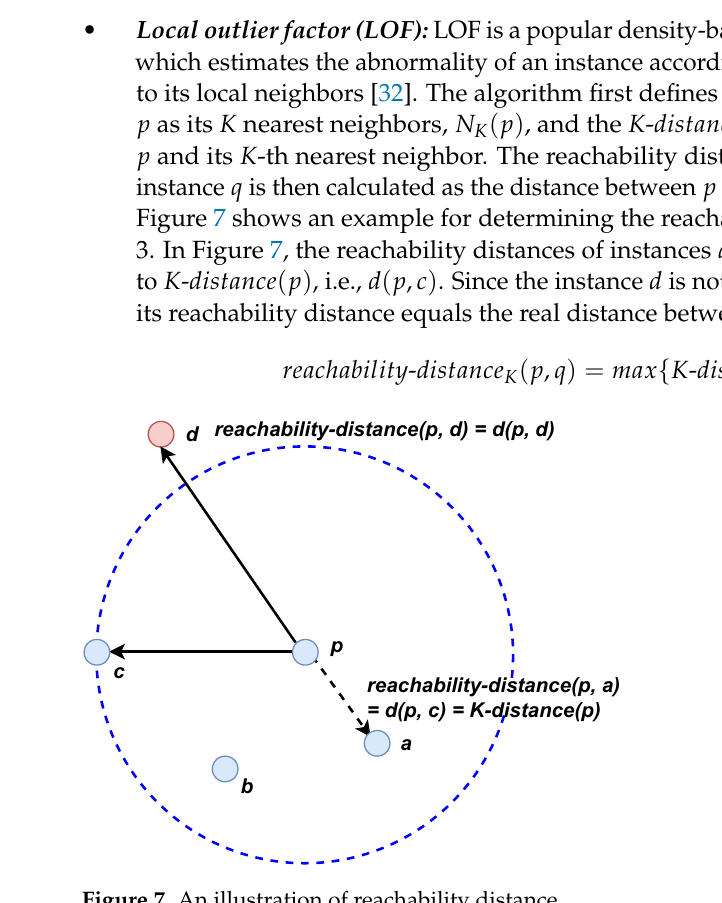
Figure 7. An illustration of reachability